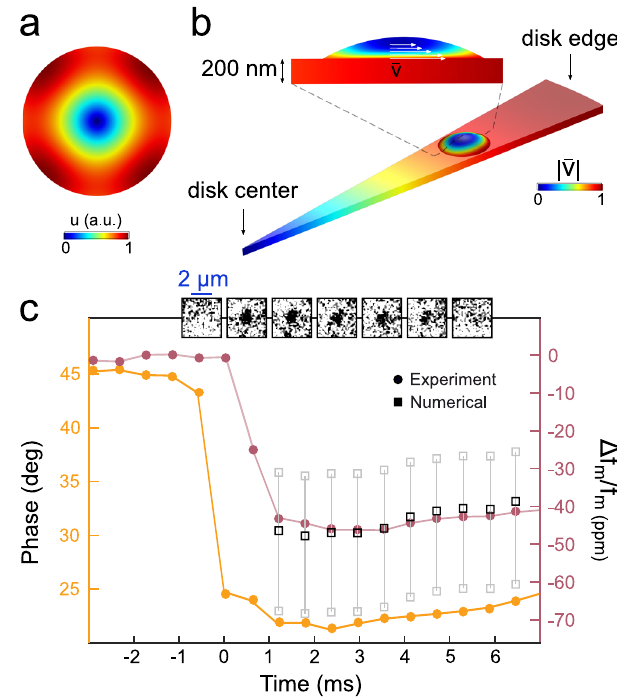
Fig. 2 | Optical measurement of the landing droplet through the disk WGM. a Top: Frames acquired with our fast camera, extracted from the top-view of the disk (left). Bottom: Experimental optical data acquired during the landing of a singledropletontheresonator.Thevoltageofthephotodiodechangesabruptlyat t =0 as a consequence of the landing. b Electric fi eld intensity for a (TE) WGM at 1.55 μ m wavelength with azimuthalorder m =68 and radialorder p =10,calculated for a GaAs disk of 11 μ m radius and 200nm thickness. c A slice of the disk close to the droplet landing position is shown. Within the droplet volume, the electric fi eld decreases exponentially in the vertical direction. h d , r b , and θ b are the height, contact radius, and contact angle of the droplet.